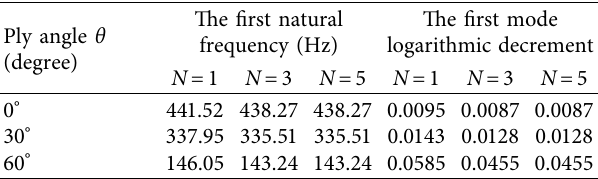
Table 2: First frequency and modal logarithmic decrement of the tapered composite cutter bar ( σ � 0 . 5 , Ω � 0 ) .